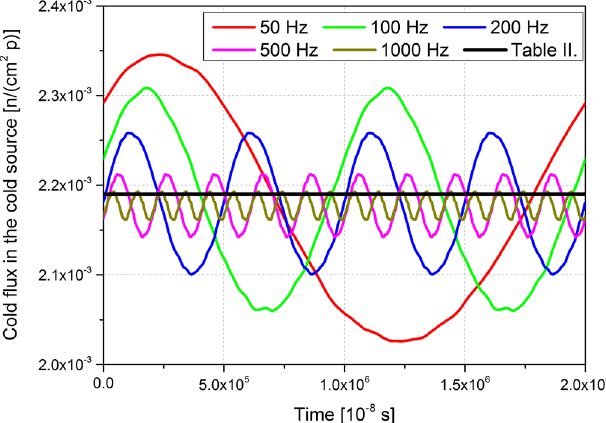
FIG. 16. The time-dependent cold (between 2.5 and 5.0 Å) neutron flux in the cold source as a function of different proton beam rotation frequencies. The straight black line at 2 . 19 × 10 − 3 indicates the value from Table III which is the time-averaged